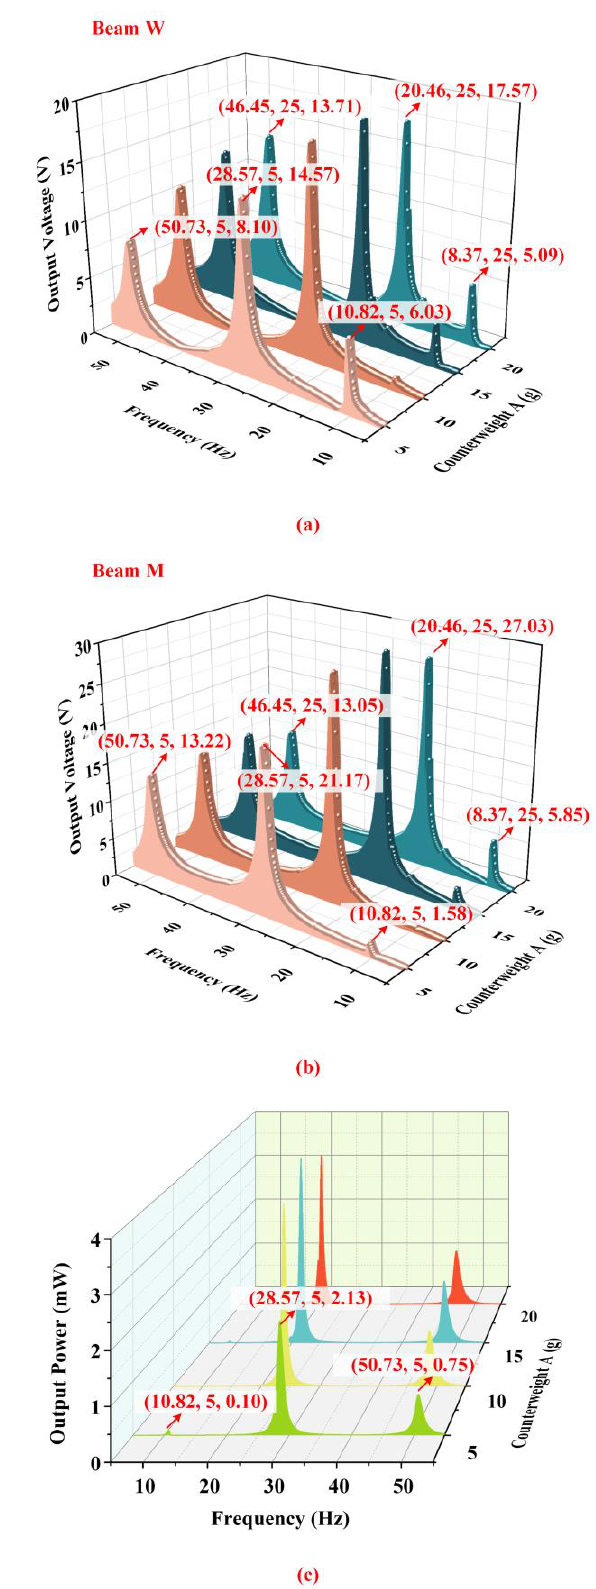
Figure 11. The output characteristics of the energy harvester with different weights of counterweight A. ( a ) The output voltage of beam W; ( b ) The output voltage of beam M; ( c ) The total output power of the harvester at 1.96 m/s 2 .